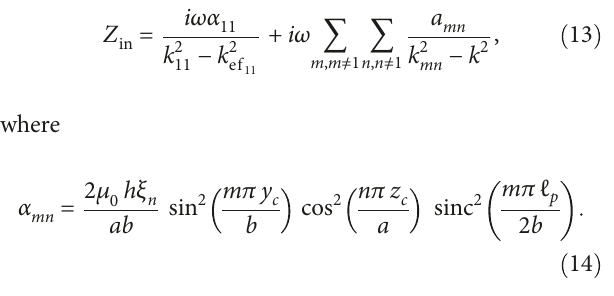
Figure 5: HB input impedance and re fl ection coe ffi cient module. 3 Table 3: Electrical characteristics of the antennas under